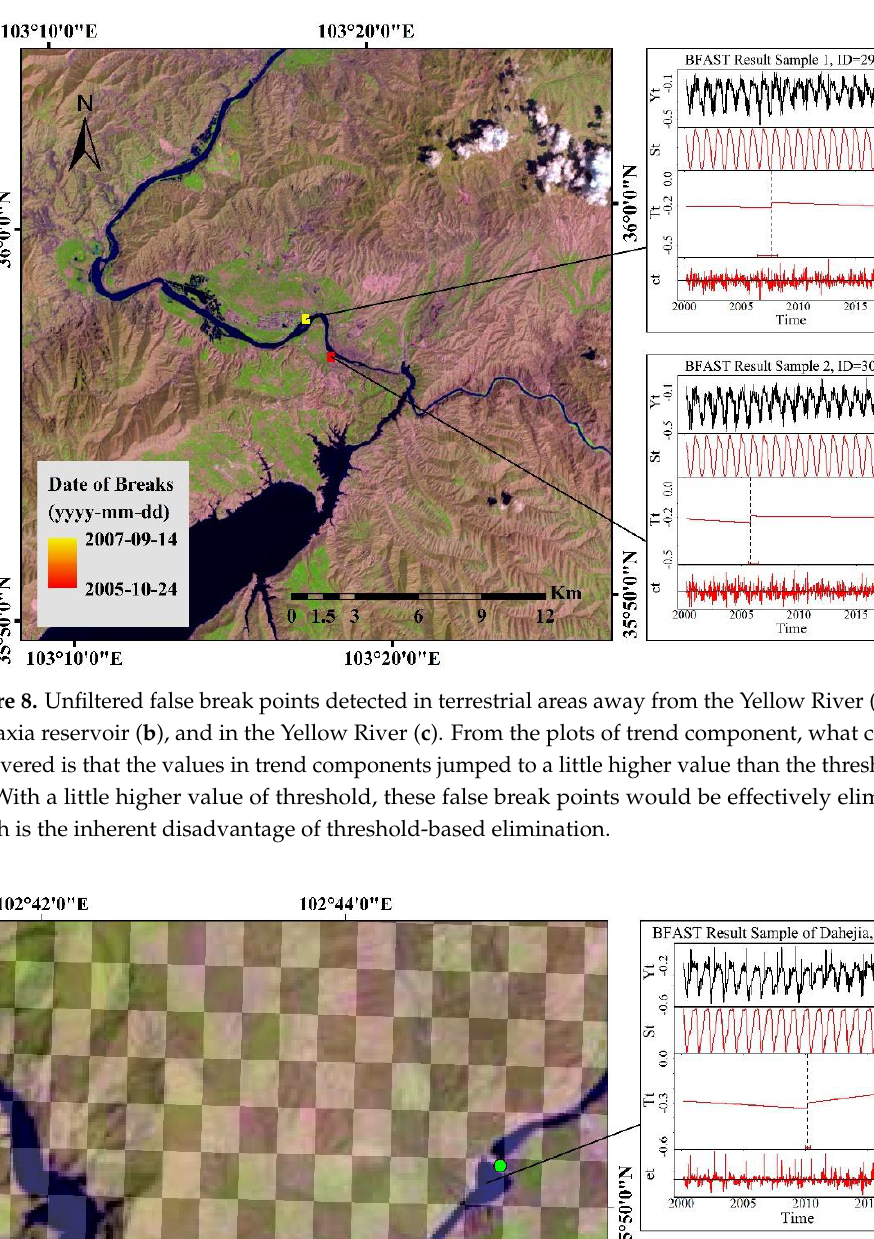
Figure 9. Landsat-8 OLI RGB synthesis image of Dahejia Reservoir with the MOD09A1 pixels in its range and the BFAST decomposition result of the pixel at the dam of it. The spatial extents of each MOD09A1 pixel was transparently shown as a chess board to illustrate that all of the pixels in Dahejia Reservoir are combined of different features, which obstructed the effectiveness of BFAST